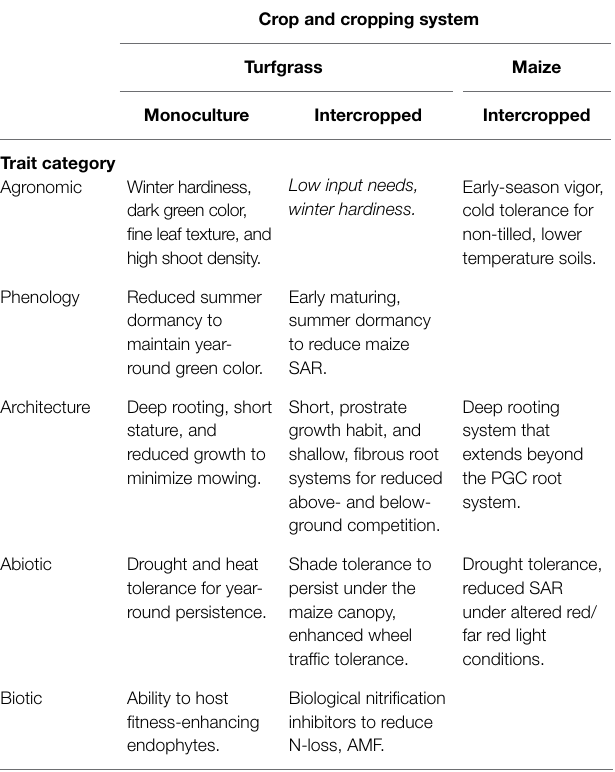
TABLE 1 | Turfgrass and maize ideotypes in monoculture and intercropping systems. Crop and cropping system